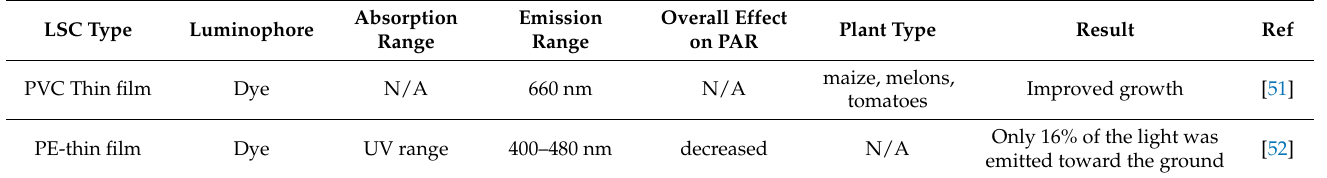
Table 3. Summary of the type of LSC devices used in CEA and their overall effect on plant